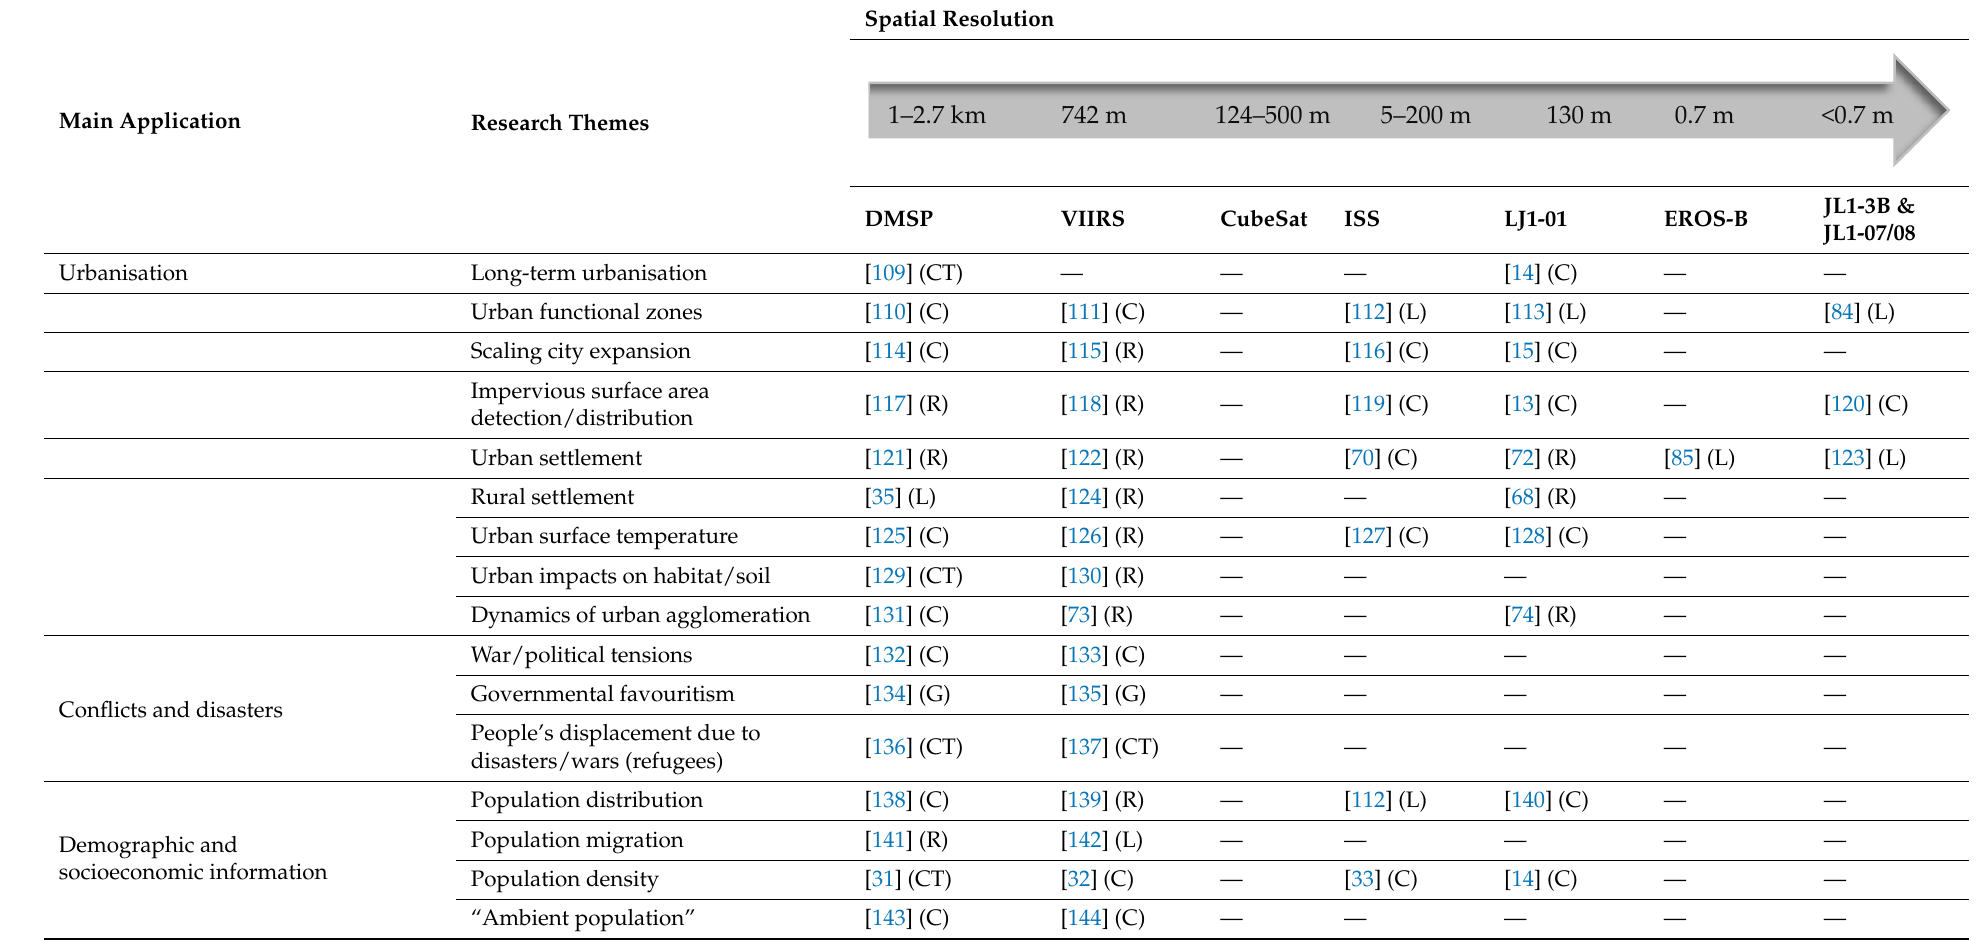
Table 3. Applications of night-time satellites by spatial resolution and location. G — Global; R — Regional, CT — Country; C — City; L — Table 3. Cont.